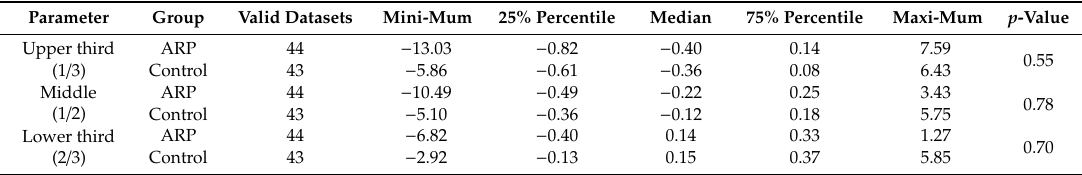
Table 2. Bone density after tooth extraction in the alveolar ridge preservation group and the control group. Mean values of the respective sectional planes were standardized with the average value of the local alveolar bone density measured in the palatal-apical direction (calculated as